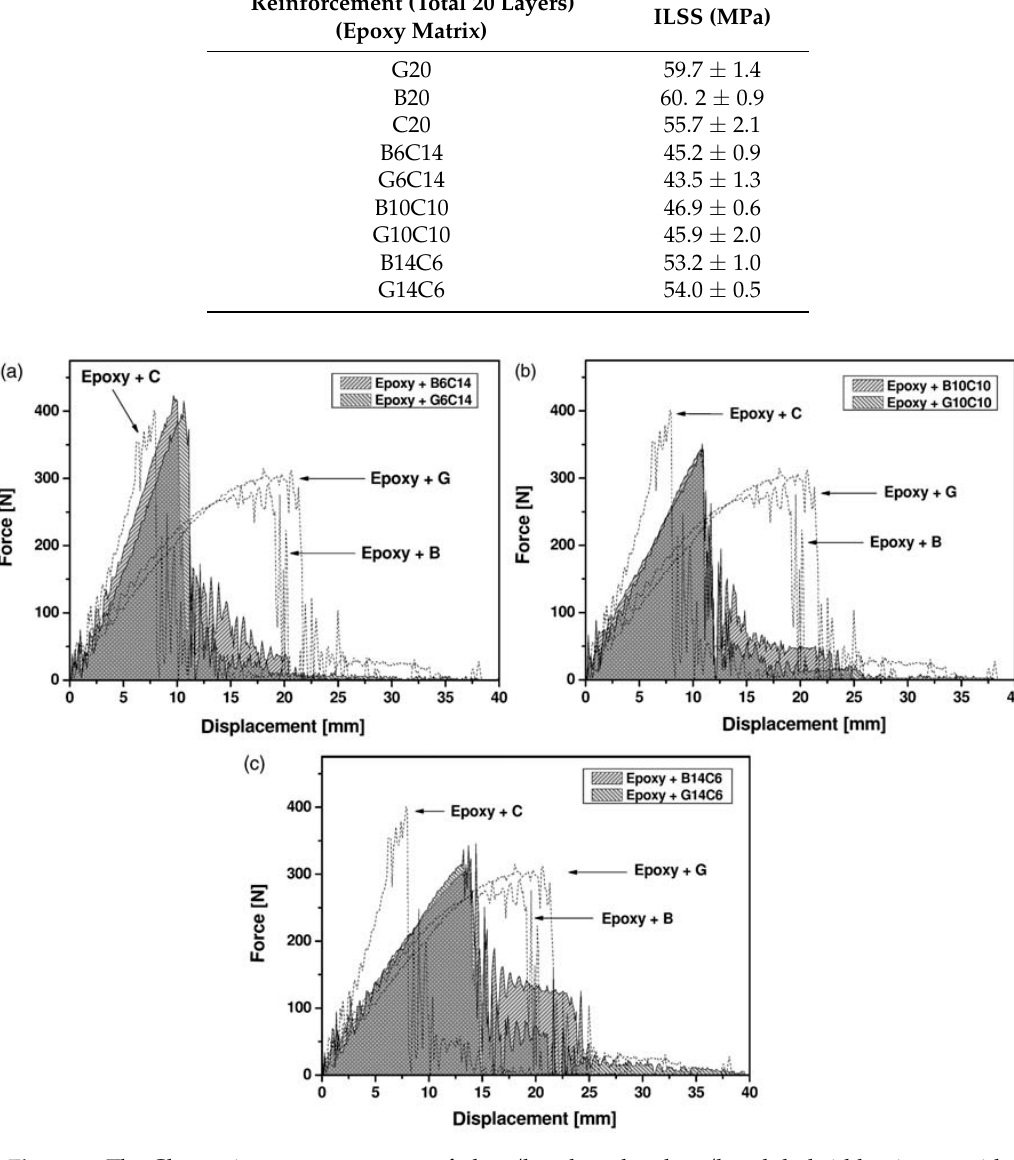
Figure 7. The Charpy impact tests curves of glass/basalt and carbon/basalt hybrid laminates with respect to the originating laminates: ( a ) Laminates with 14 carbon fiber layers and 6 layers of another fiber (glass or basalt) ( b ) Laminates with 10 carbon fiber layers and 10 layers of another fiber (glass or basalt); ( c ) Laminates with 6 carbon fiber layers and 14 layers of other fiber (glass or basalt)